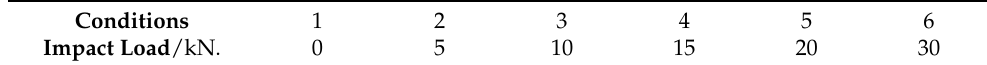
Figure 3. Numerical model of a simply supported beam. Table 2. Different impact loading conditions.